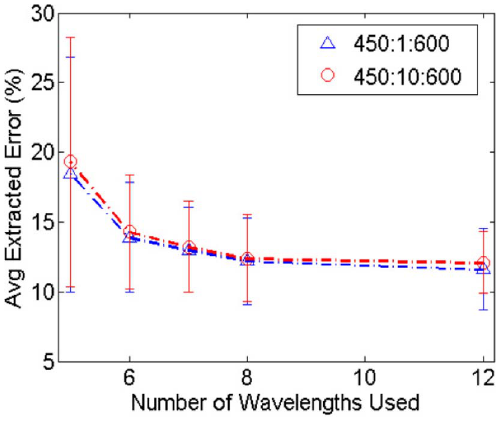
Figure 4. Average of extracted errors for tissue parameters with increasing number of wavelengths. Average extracted % error of [THb], [ b c], and , m s ’ . for 5, 6, 7, 8, and 12 total wavelengths selected from 450–600 nm in 1 and 10 nm